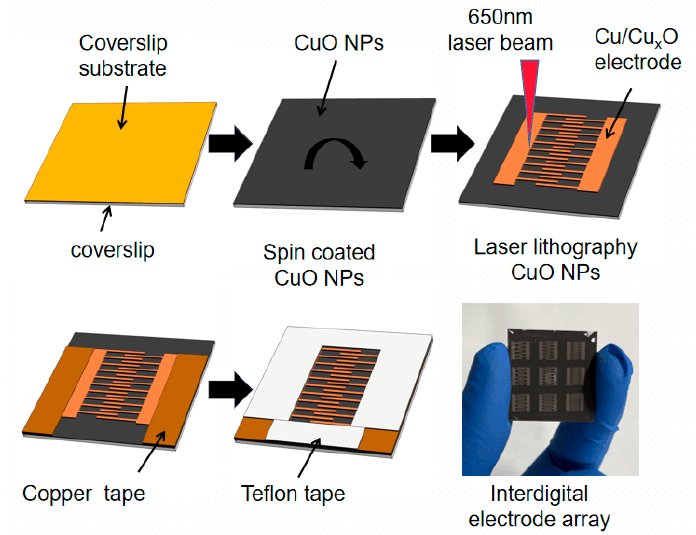
Figure 1. Schematic diagram of humidity sensor manufacturing process.